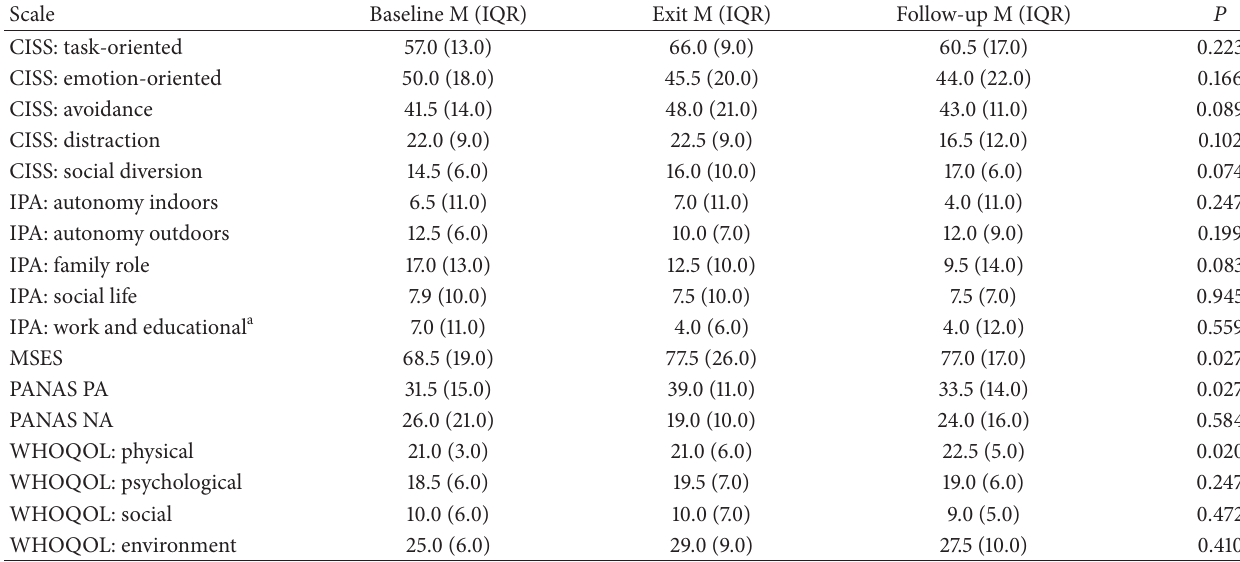
Table 3: CROP baseline, exit, and follow-up scores ( 𝑛 =